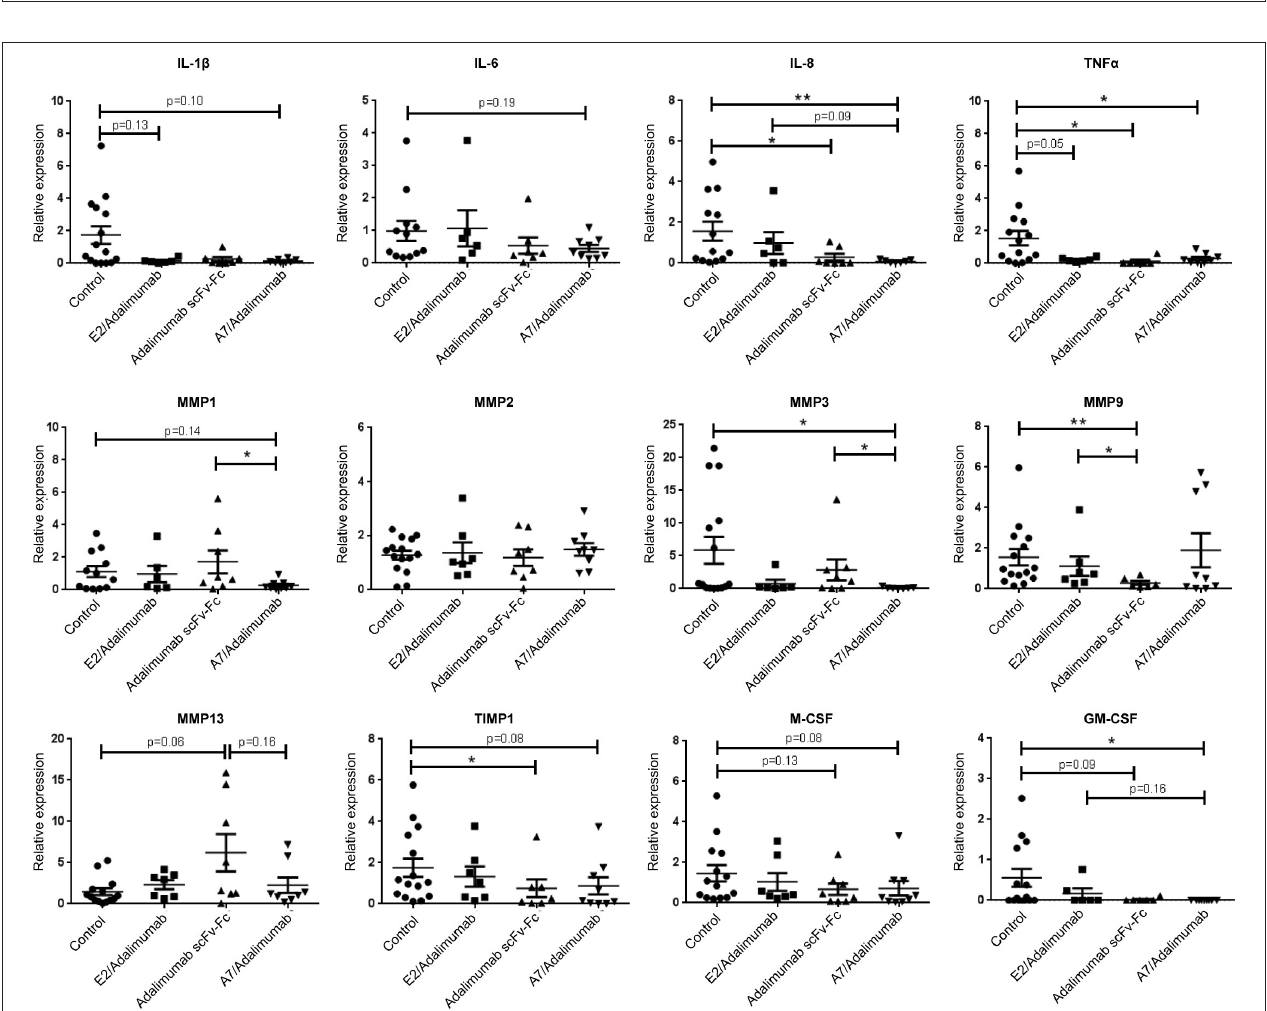
FIGURE 5 | mRNA expression profiling in human synovium xenografts. mRNA expression in synovium grafts from mice receiving PBS and A7 scFv-Fc (control), adalimumab scFv-Fc, A7/adalimumab, or E2/adalimumab were represented as relative expression compared to the median of the control group. Grafts were harvested 7 days after second injection. Control n = 16; adalimumab scFv-Fc n = 8; A7/adalimumab n = 9; E2/adalimumab n = 7. Values were expressed as mean ± SEM. Mann–Whitney non-parametric test (* p < 0.05, ** p < 0.01).